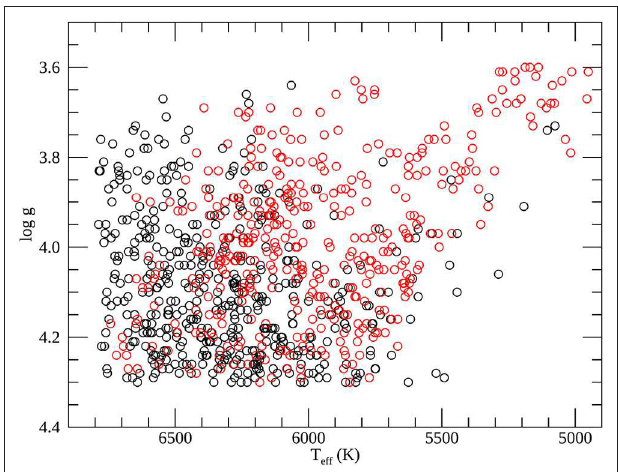
FIGURE 3 | Hertzprung-Russel Diagram for the stars selected as described in section 2.3, with A max,pred / Noise > 0.94, T eff < 6,800 K , and log g < 4.3 dex . Stars without detected oscillations are represented with black circles and stars with detected oscillations in red